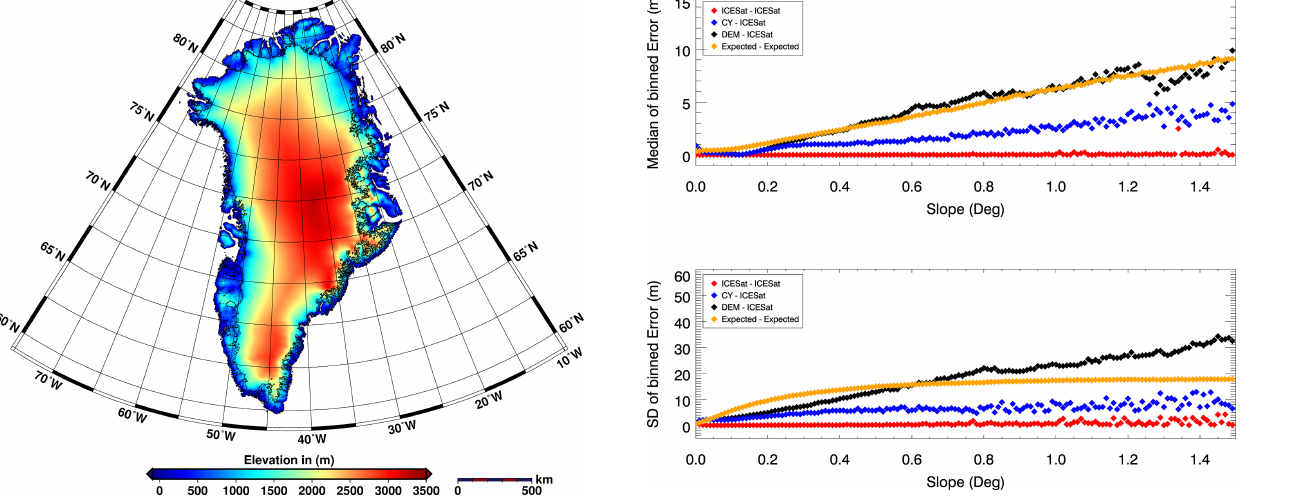
Figure 7. New elevation model of Greenland derived from CryoSat-2.